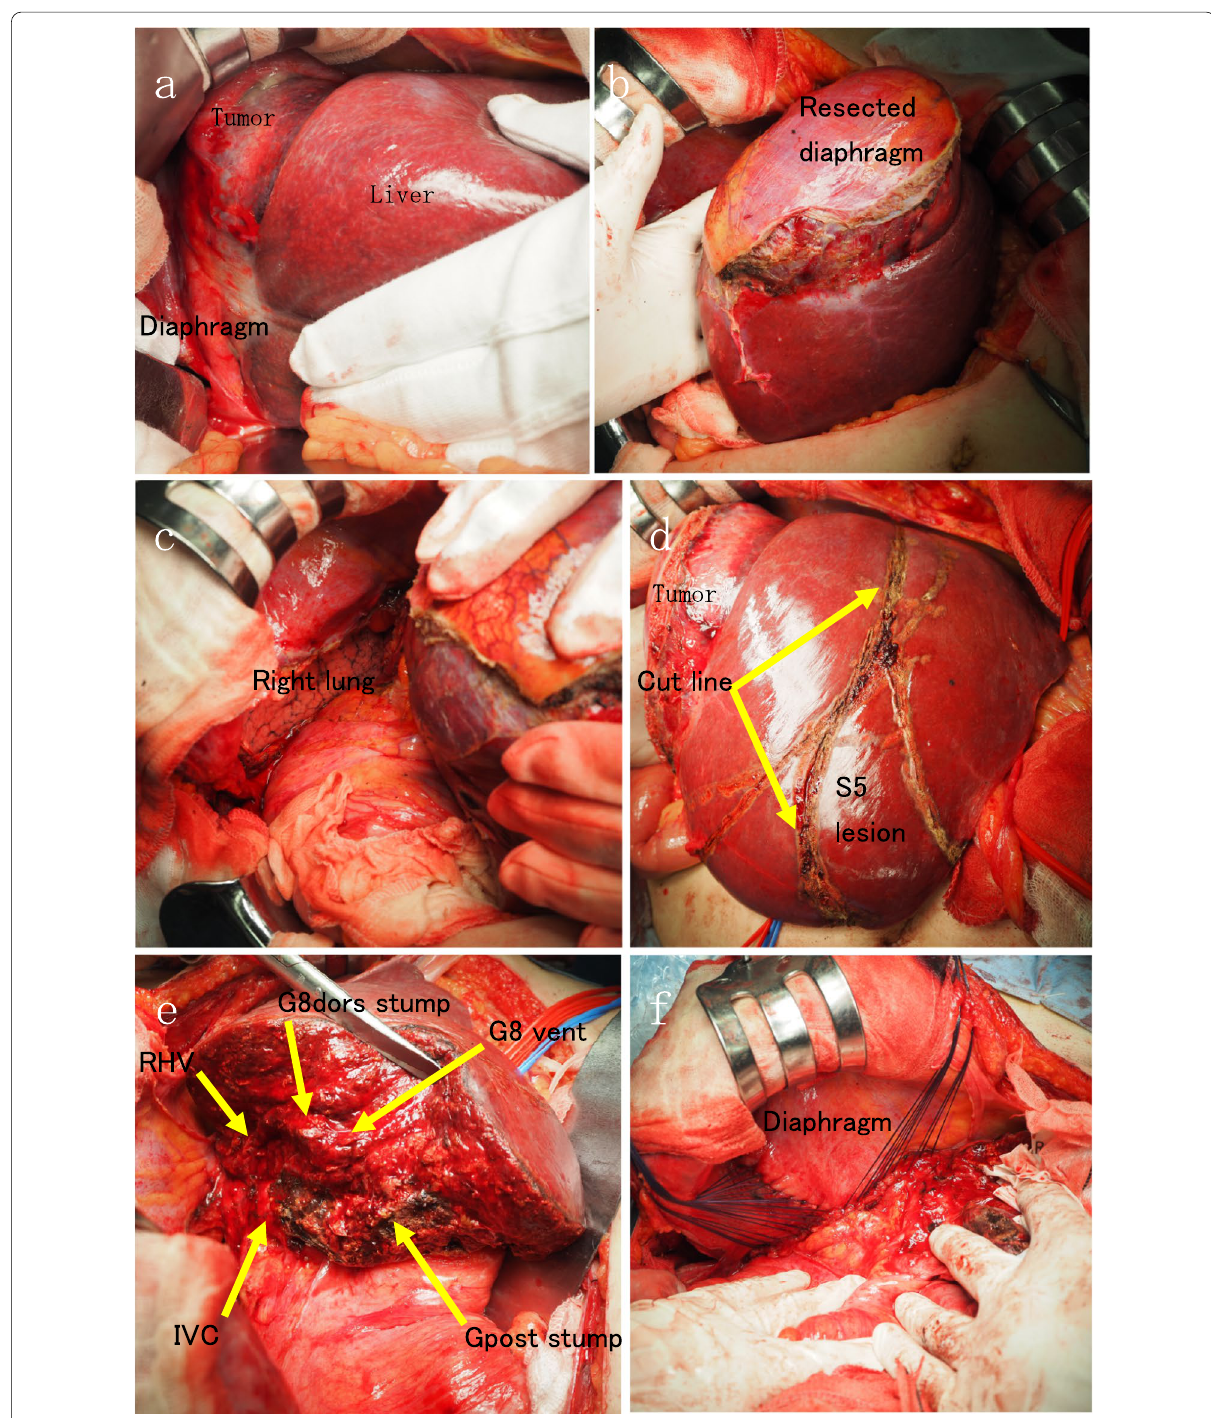
Fig. 2 Surgical procedure. a Separation of the tumor from the liver was not possible. b , c Combined resection of the diaphragm was performed. d By clamping A5, we found the boundary between S5 and S6. e We performed extended right posterior segmentectomy (S6, 7, 8dors resection). f simple closure of the diaphragm was